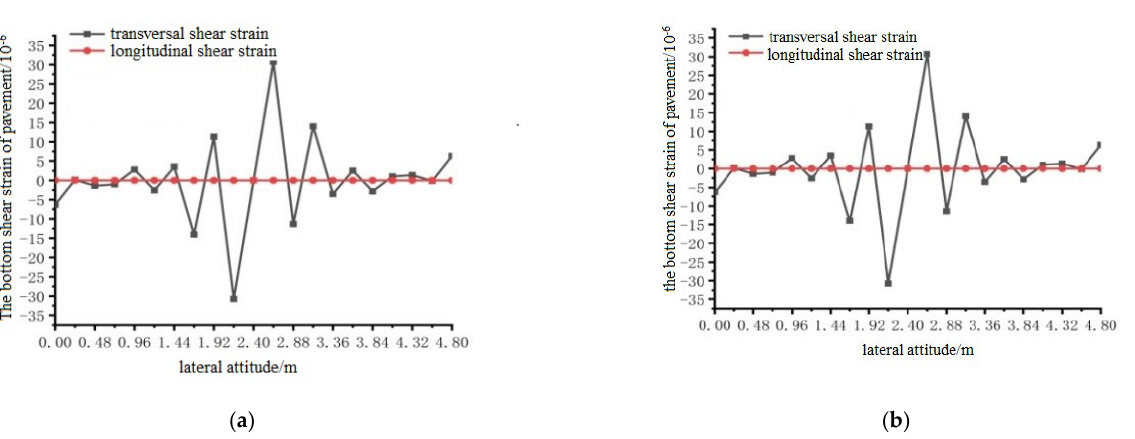
Figure 33. The transverse distribution of longitudinal and transverse shear strain on the surface of the pavement with and without temperature field under the action of load level 1. ( a ) Longitudinal and transverse shear strain diagrams without temperature field effect; ( b ) Longitudinal and transverse shear strain diagrams with temperature field effect.